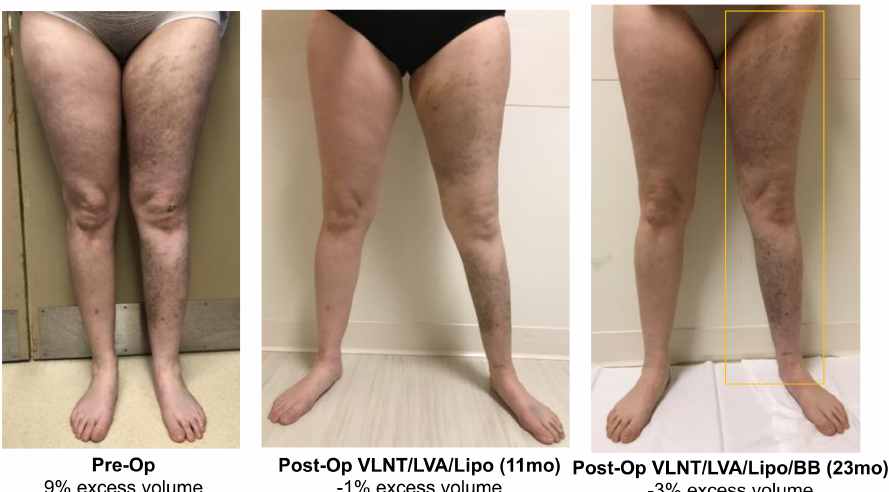
Figure 5. Lower extremity with 9% volume excess reduced to − 1% at 11 months following VLNT/LVA and liposuction. BB placement at 12 months post-op resulted in − 3% volume excess at 23 months following triple therapy surgical management. In the 8 upper extremity patients, a median excess volume ratio of 34% (17, 44%) was observed at baseline. Excess volume improved to 1.0% ( − 4.3, 9%, p < 0.0078) after first stage surgery measured at 13 months, and 0.0% ( − 2.5, 2%, p < 0.0078) after completion of triple therapy treatment at 23 months. For the 6 lower extremity cases, median excess volume ratio of 24% (20, 37%) was identified at baseline. Excess volume ratios improved to − 0.5% ( − 4.5, 2.3%, p = 0.0313) after first stage surgery at 16.7 months, and − 2.5% ( − 4.3, − 0.5%, p = 0.0313) after completion of triple therapy approach at 27.3 months (Table 3, Figure